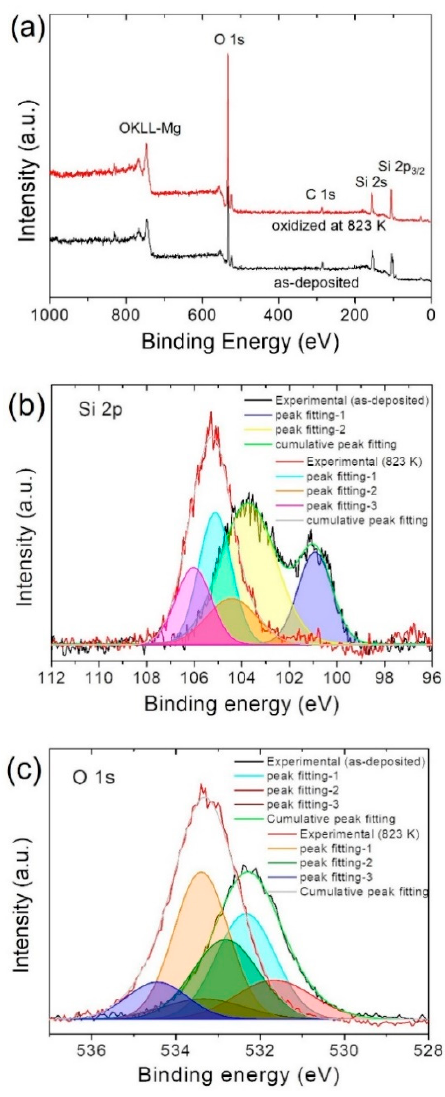
Figure 5. ( a ) X-ray photoelectron spectroscopy (XPS) survey spectra, ( b ) Si 2p spectra, and ( c ) O 1s